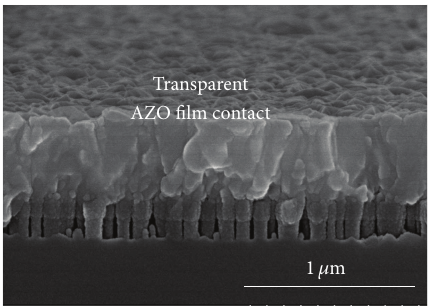
Figure 7: Cross-sectional SEM image of n-AZO/p-SiNP sample showing high density Si nanopillars with top AZO transparent electrode [20].